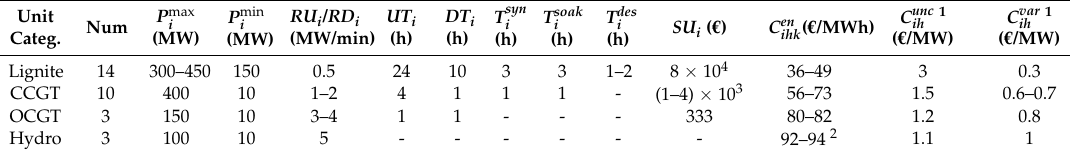
Table 1. Summary of the generation techno-economic data for the modified Greek power system. Unit